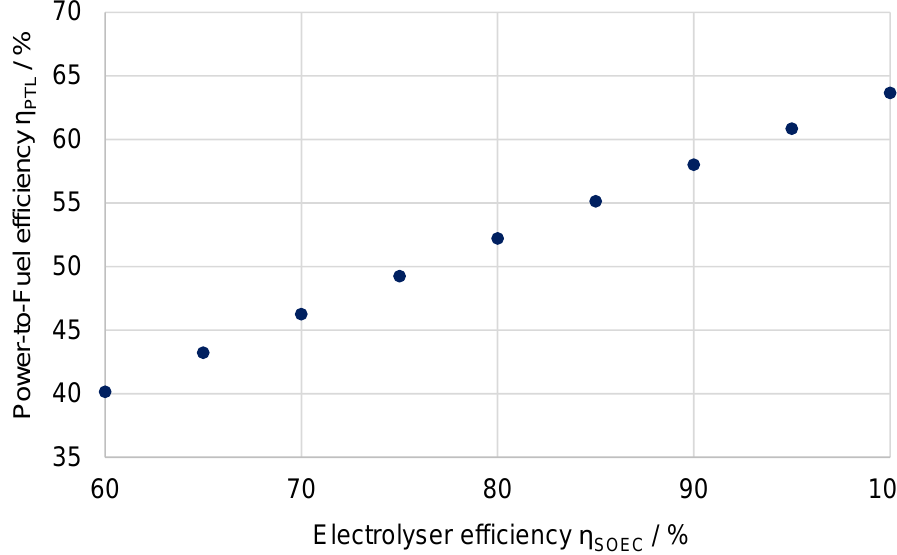
Figure 13. Power-to-fuel efficiency as a function of electrolysis efficiency.